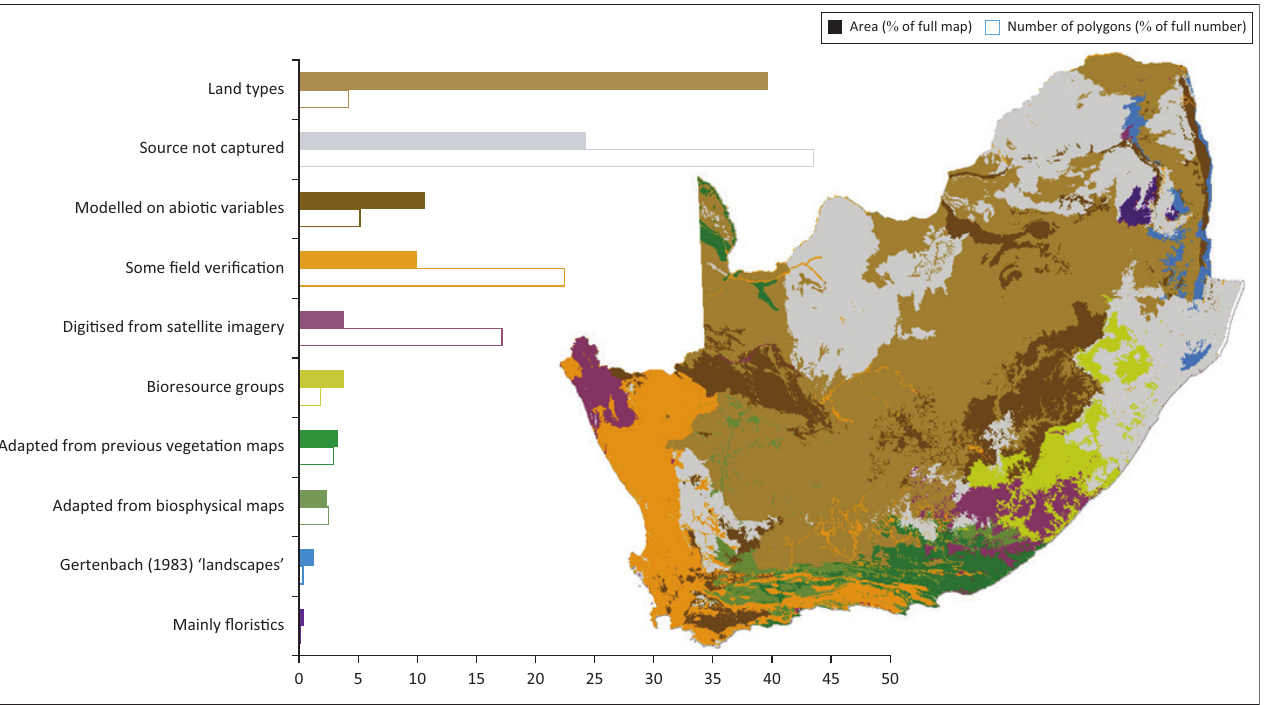
FIGURE 3: Sources of data that informed the mapping of vegetation types from 2006 to 2018 are shown. The percentage area influenced by a data source (as a proportion of the total area of the National Vegetation Map to date) is shown in solid, coloured bars. The percentage of polygons affected by that data source is shown in clear bars with coloured outlines. ‘Not captured’ indicates vegetation types for which the 2006 data source could not be